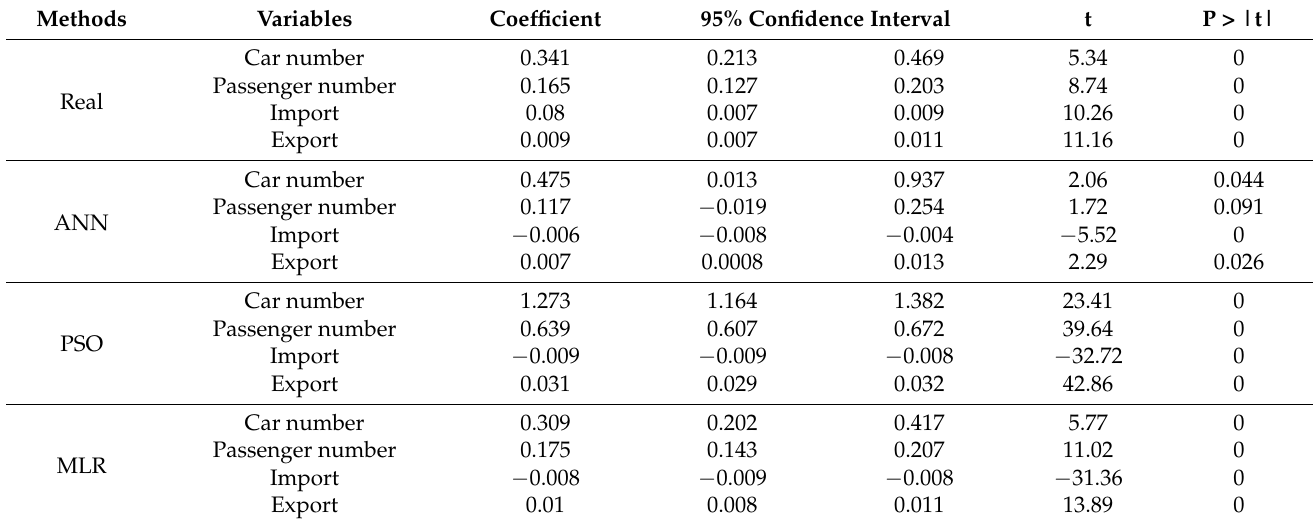
Table 7. Statistical values of Gokceada independent variables according to the